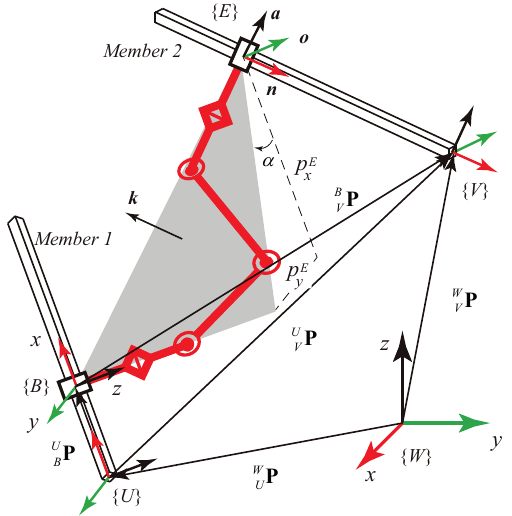
Figure 5. The diagram for transition